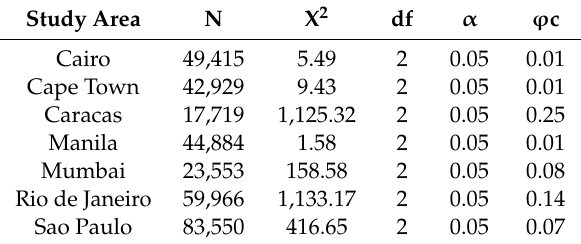
Table 4. Results of chi-squared test of